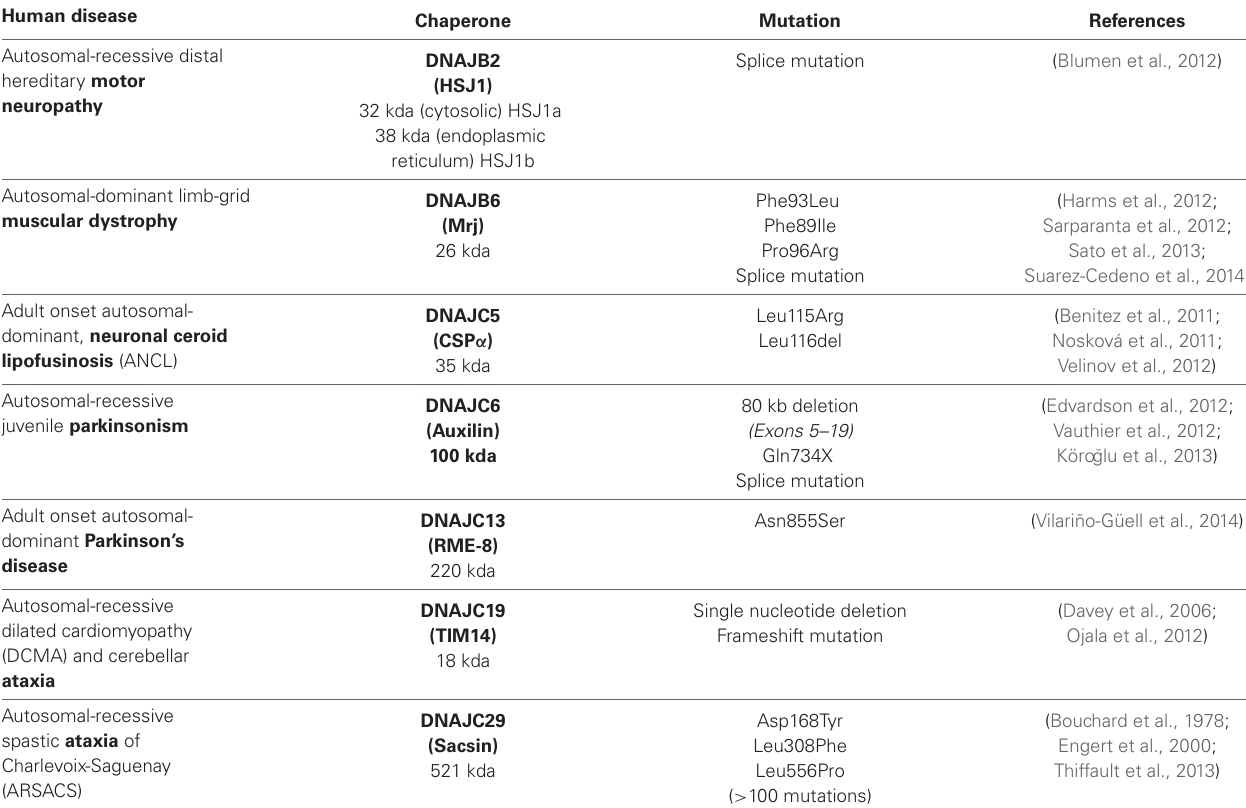
Table 1 | J proteins mutations and resulting proteostasis consequences in human diseases